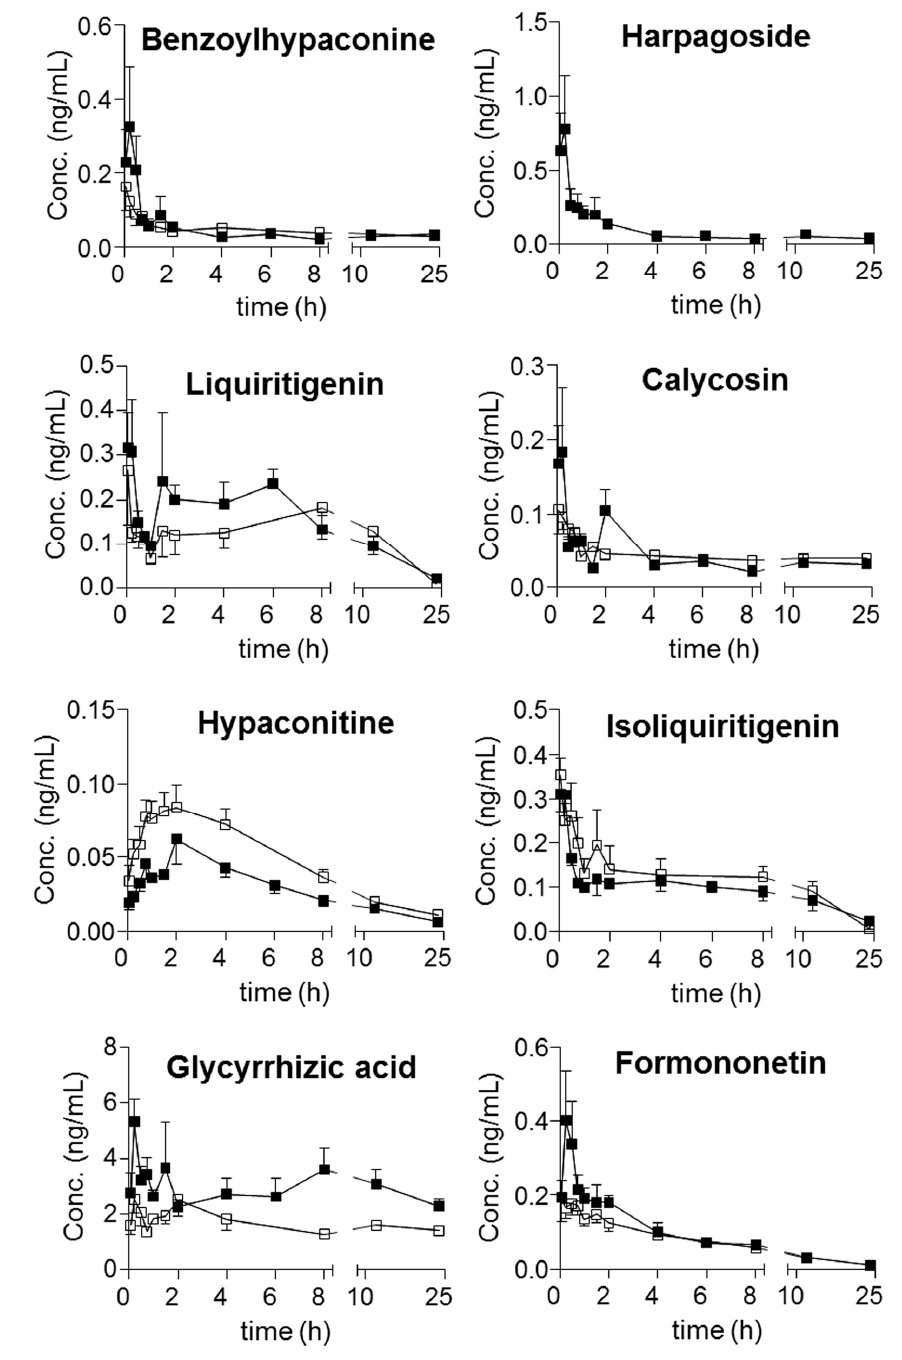
Figure 3 . Cont. Figure 3.